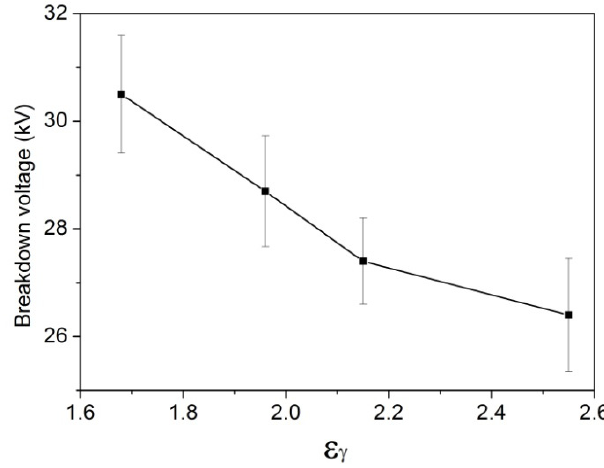
Figure 8. Effect of the handsheet relative permittivity on the breakdown voltage of the composite insulation